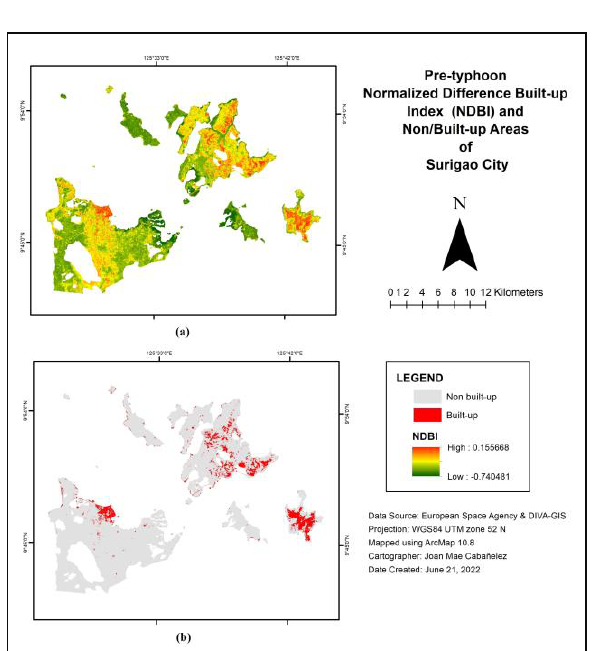
Figure 11 . NDBI and built-up layers of Surigao City during pre-typhoon condition.